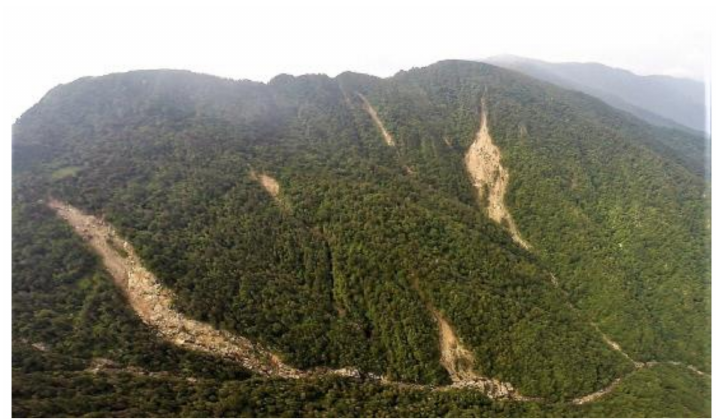
Figure 6. Landslide events that occurred in the Jirisan Jeseokbong area in August